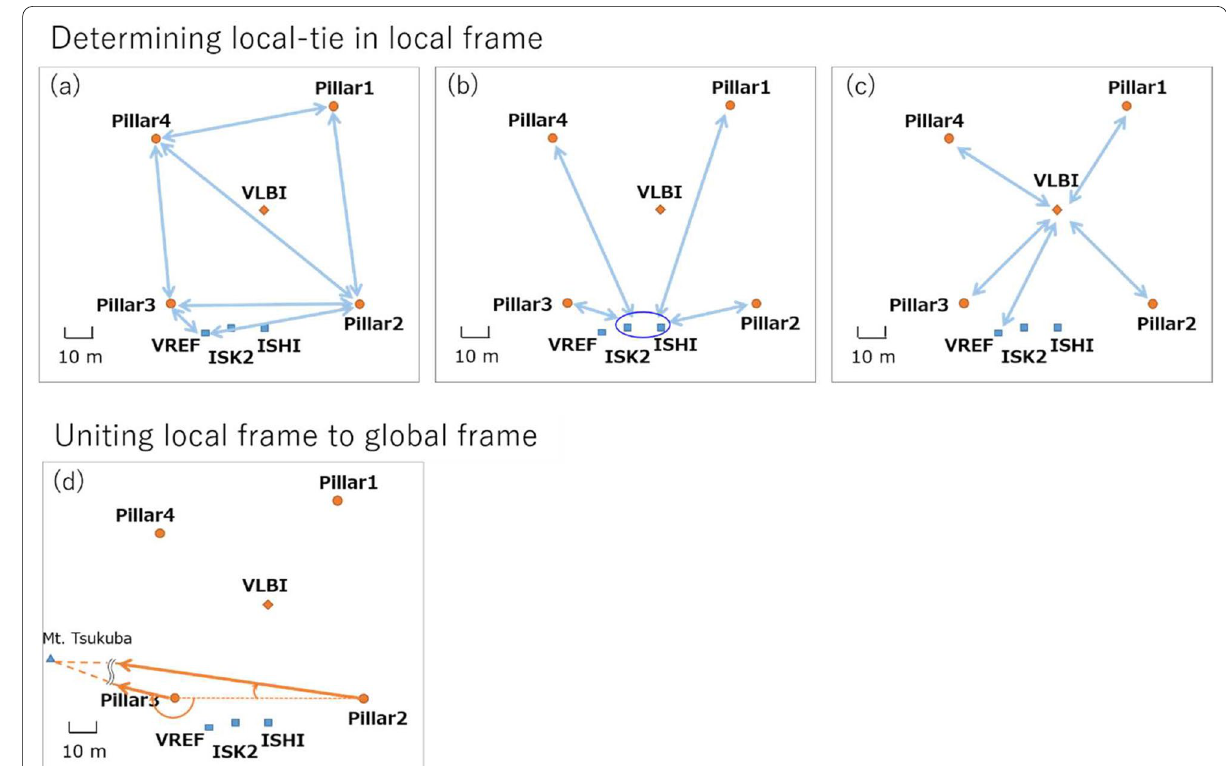
Fig. 2 Outline of co-location survey. a Measuring the positional relations of pillars; b measuring the positional relations between pillars and ARP of GNSS; c measuring the positional relations between pillars and IVP of VLBI; d measuring the orientation